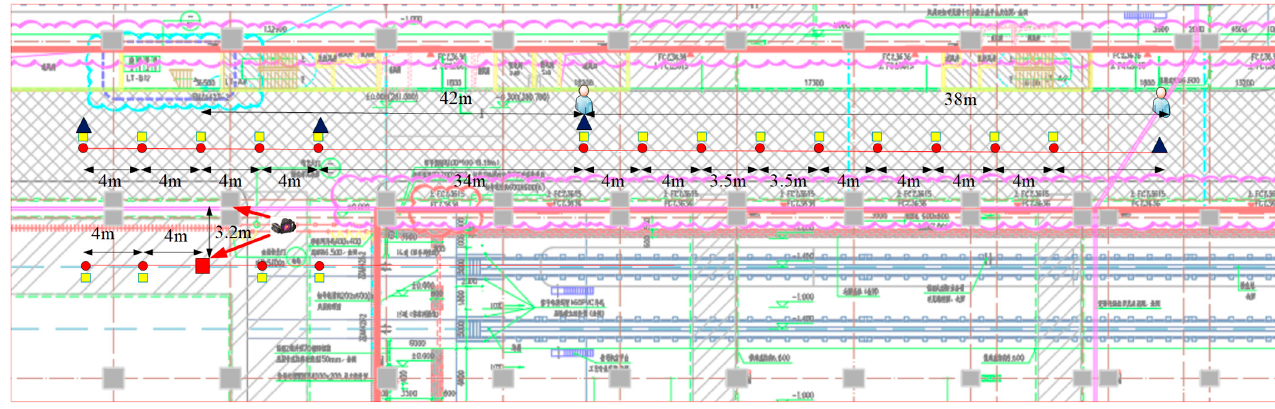
Figure 13. Measuring points distribution.